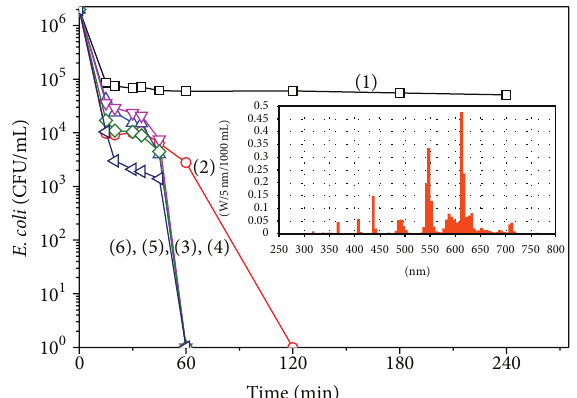
Figure 14: Loss of bacterial viability of E. coli under Osram Lumilux 18W/827 irradiation mediated by TiO 2 -polyester HT prepared samples with a TiO 2 loading: (1) polyester alone, (2) 0.05% (3) 0.1% (4) 0.5%, (5) 1%, and (6)